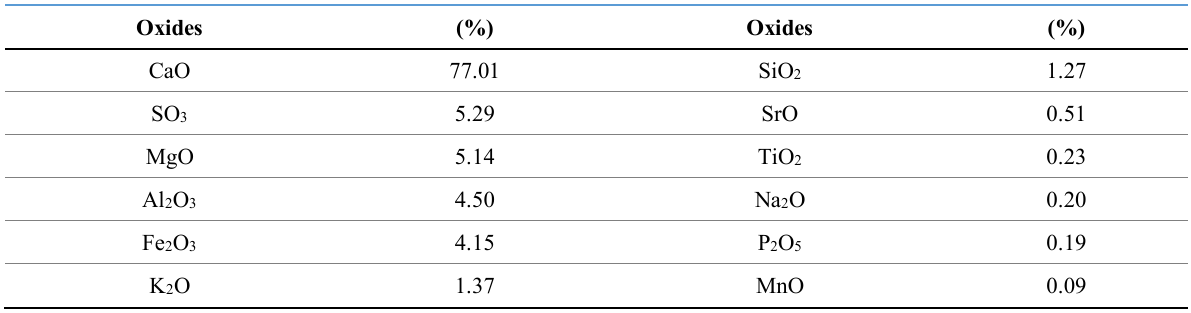
Table 1. Chemical characterization of cement CPV-ARI Oxides (%)